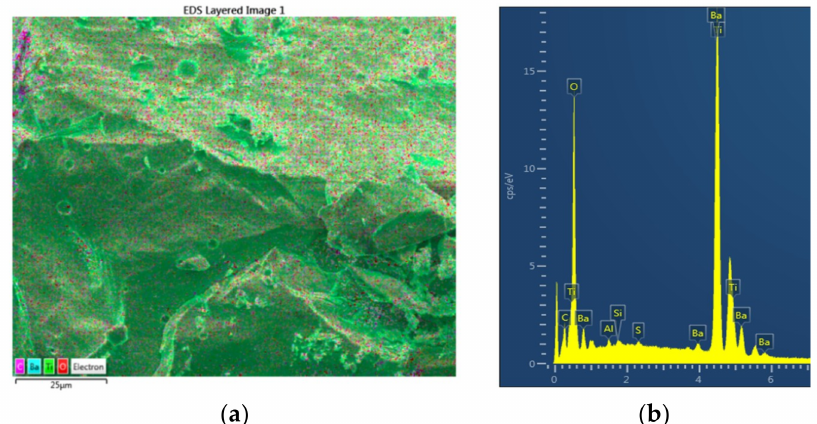
Figure 6. BaTiO 3 (fresh) used in the experiments. ( a ) Energy Dispersive X-ray Spectroscopy (EDS) layered image, ( b ) Surface EDX spectrum with: [O] = 0.611; [Ti] = 0.196; [Ba] = 0.193; [Ti] / [Ba] = 1.02; [O] / ([Ba] + [Ti]) =